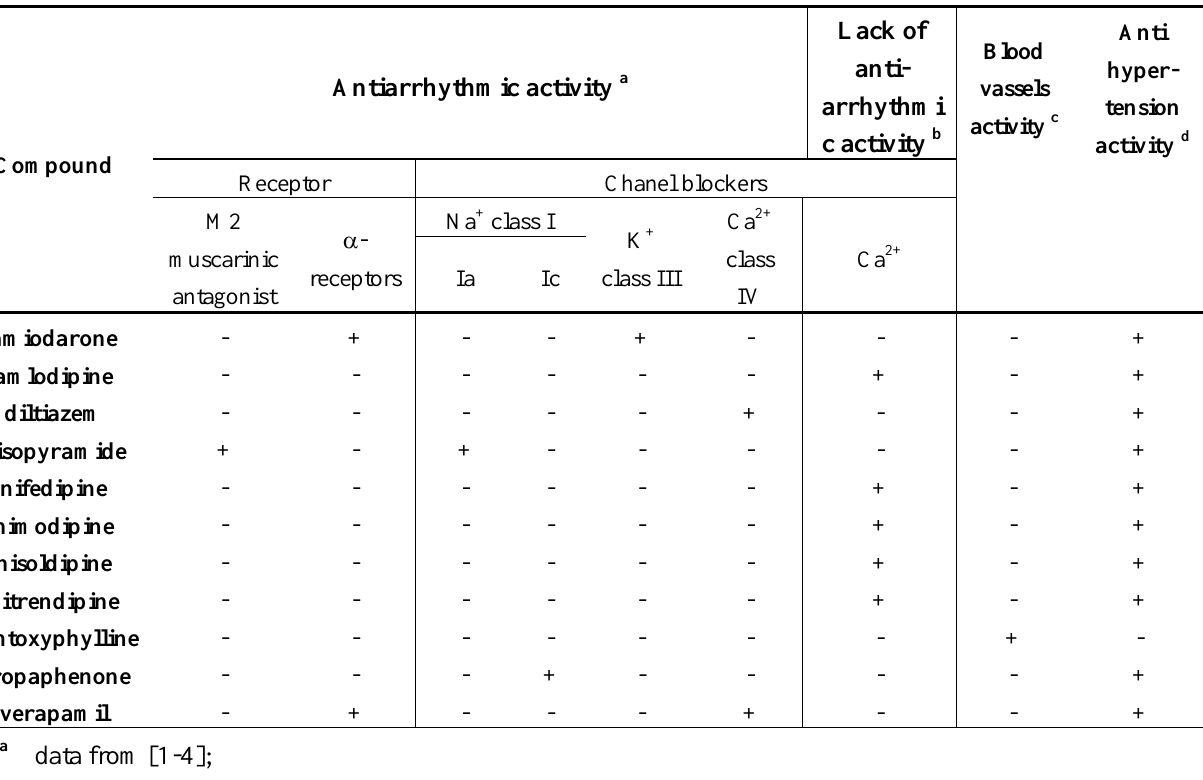
Table 1. The classification of the 11 studied cardiovascular system drugs according to their pharmacological